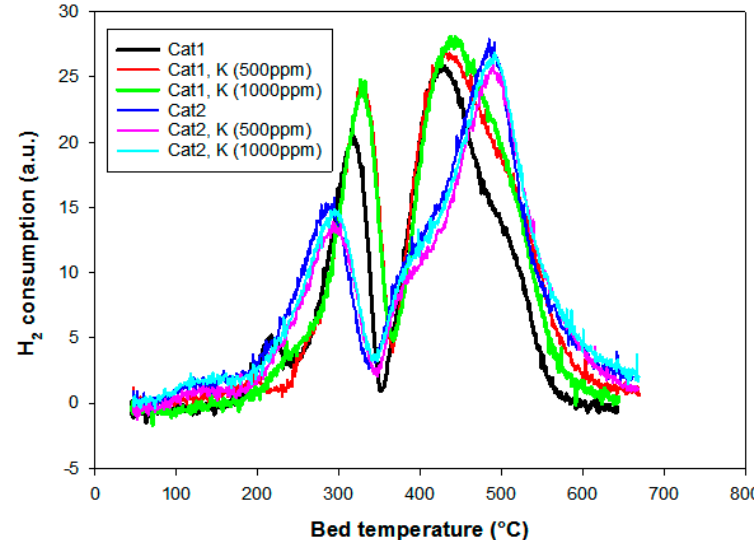
Figure 3. Temperature-programmed reduction (TPR) profiles of the catalysts Cat1 and Cat2 with different K loadings.